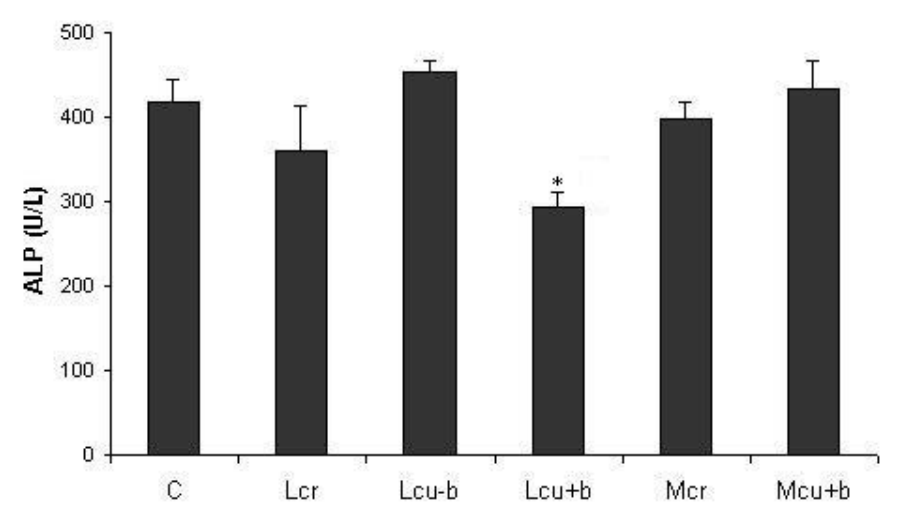
Figure 3. Activity of alkaline phosphatase [ALP (U/L)] in control and treated groups (Lcr, Lcu-b, Lcu+b, Mcr and Mcu+b) after two months of treatment. The values are expressed as mean ± SEM (n = 6). Significant levels observed are * p ≤ 0.05 compared with control group